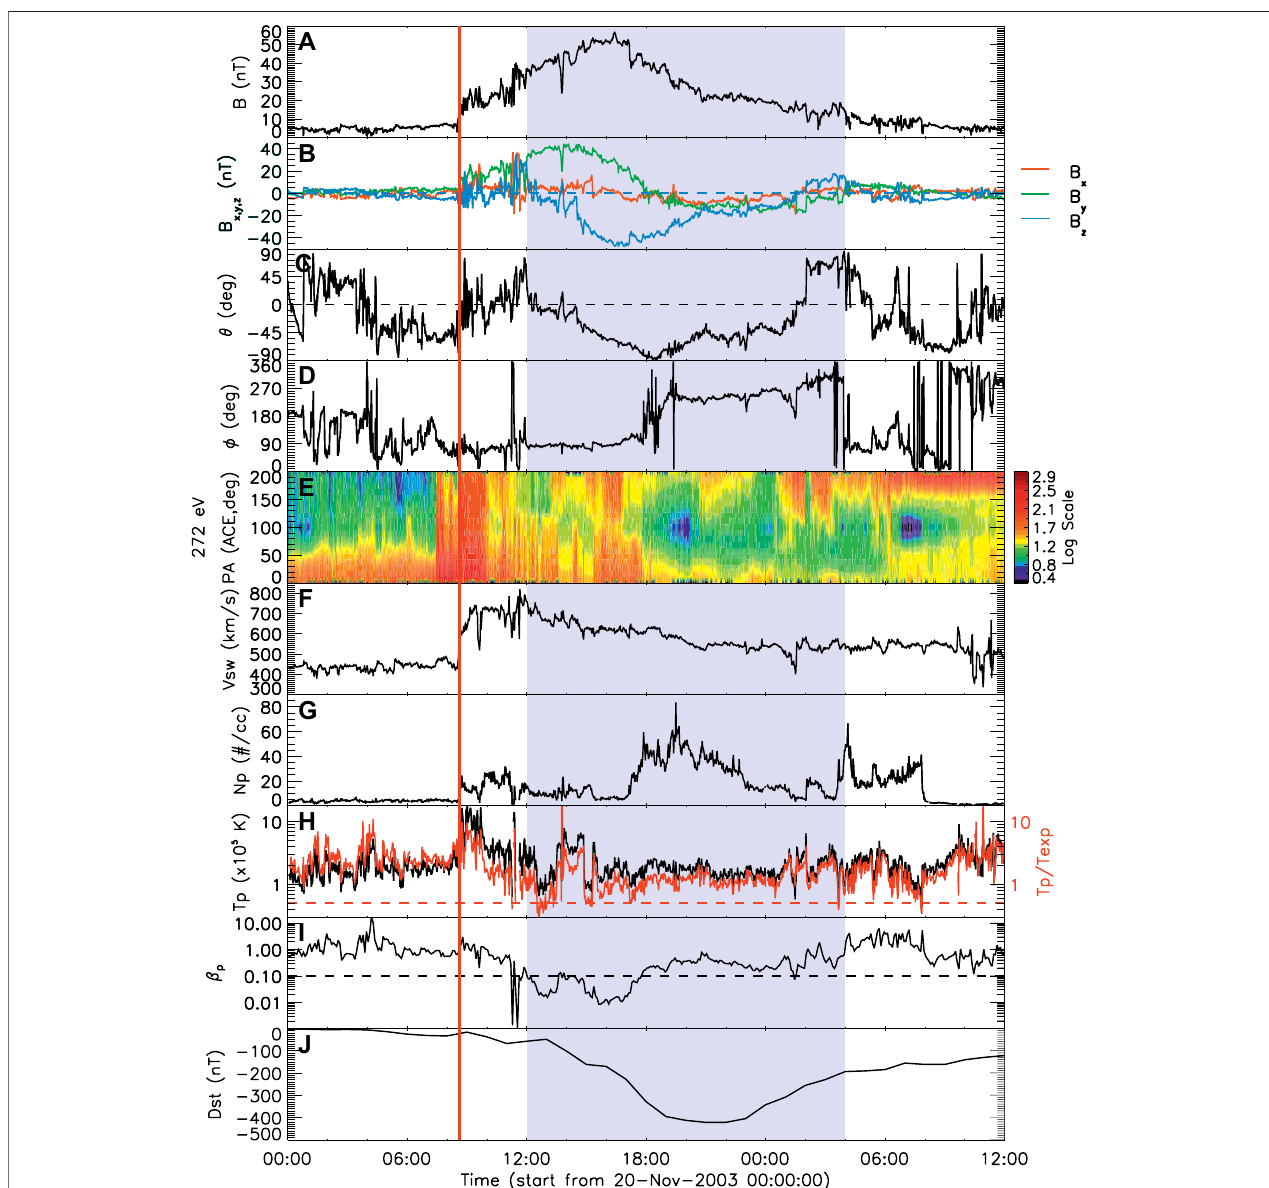
FIGURE 1 | Wind observations from 2003 November 20 00:00 to 2003 November 21 12:00. From top to bottom, the panels are: (A) the magnetic fi eld strength ( | B | ), (B) the x,y, and z magnetic fi eld componentsin GSE coordinates; (C, D) the elevation θ and azimuth ϕ of fi eld direction in GSE; (E) the suprathermal electron pitch- angle distribution; (F) the solar wind speed; (G) the proton density N p ; (H) temperature (red, expected temperature); (I) proton β ; (j) D st index. The red vertical line indicates the arrival time of shock. The gray shadow regions indicate the intervals of the